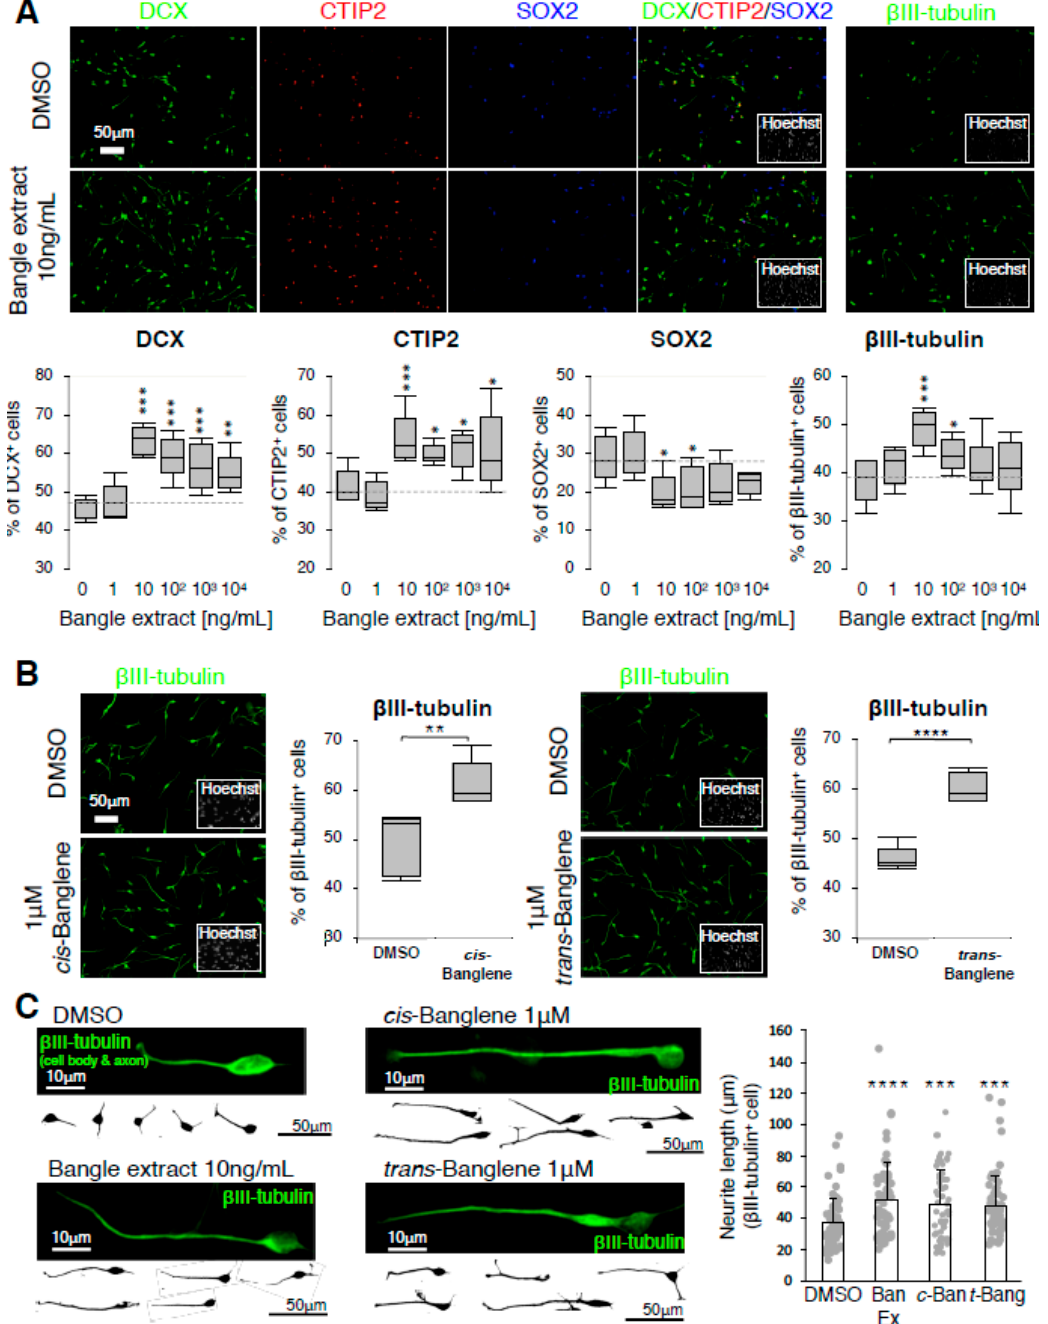
Figure 1. Bangle extract promotes neuronal differentiation of human fetal neural stem cells (hfNSCs) and enhances neurite outgrowth of premature neurons. ( A , B ) Cells treated with a series of concentrations of Bangle extract and 1 µM cis/trans -Banglene were stained with several antibodies 7 days after induction of differentiation. The graphs indicate the percentage of total cells that were DCX-, CTIP2-, SOX2-, or β III-tubulin-positive. The values shown are the means ± SD. ( N = 5, ANOVA, * p < 0.05, ** p < 0.01, *** p < 0.005, **** p < 0.001). ( C ) Representative images of single β III tubulin-positive neurites 4 days after induction of neuronal differentiation. Neurite length of immature neurons differentiated from hfNSCs is shown as mean ± SEM. ( N = 60, *** p < 0.005, **** p < 0.001). Grey dots represent the value from individual cells.